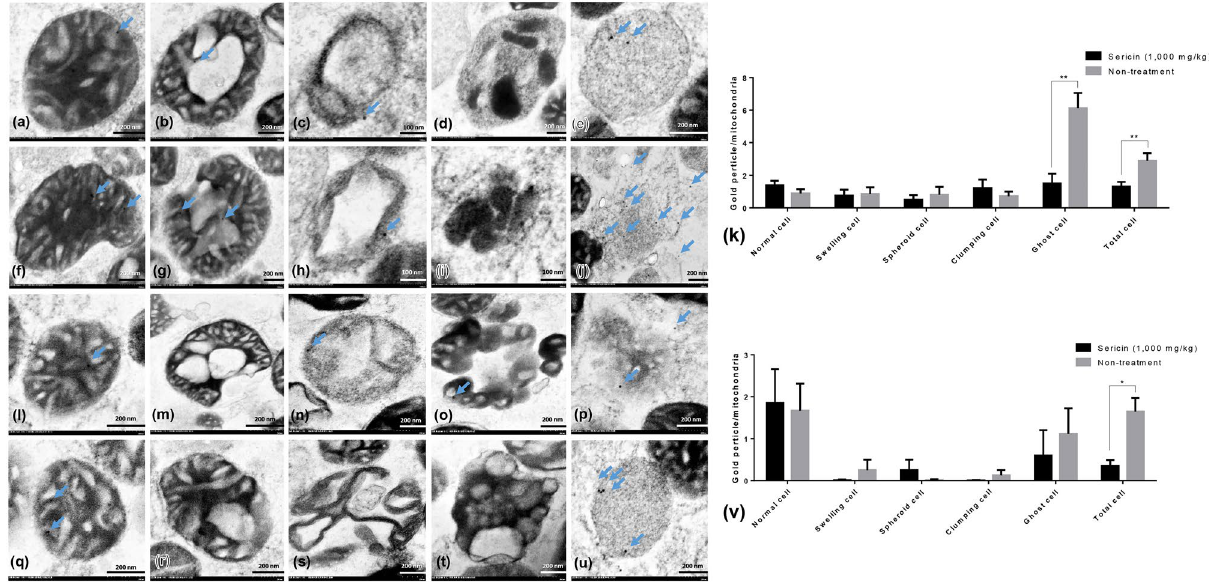
Figure 3. NDUFS1 and caspase-3 immunogold labelling at each stage of mitochondrial degeneration. NDUFS1 ( a – k ) and caspase-3 ( l – v ) gold labelling at all stages of liver mitochondrial degeneration: intact ( a , f , l and q ), swelling ( b,g,m and r ), spheroid ( c , h , n and s ), clumping ( d , i , o and t ) and ghost ( e , j , p and u ). Data in the bar graph is represented by mean ± SEM; *p < 0.05 and **p < 0.01.